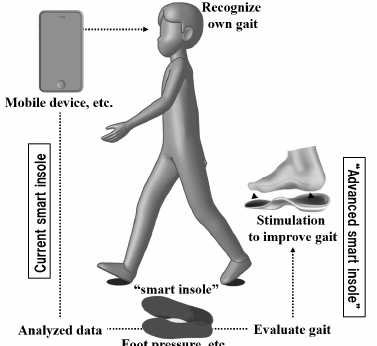
Figure 1. Schematic of the “advanced smart insole”.